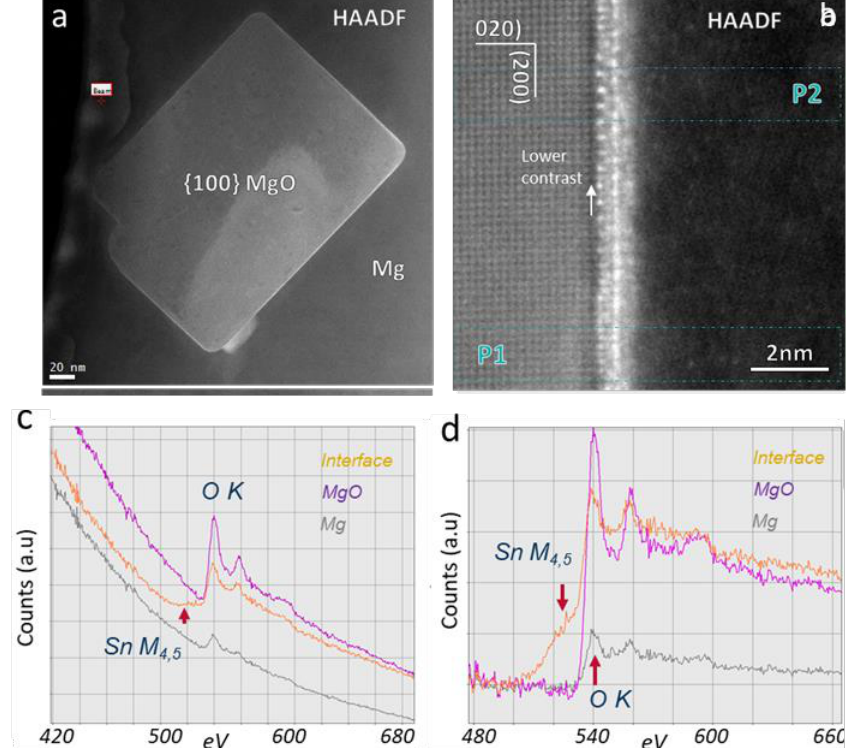
Figure 31. Sn segregation at Mg/(1 0 0)Mg interface [29]. ( a , b ) STEM HAADF images showing ( a ) general view of a {1 0 0} cubic MgO and ( b ) the Mg/MgO interface viewed in [0 0 1]MgO direction; and ( c , d ) the EELS spectra without and with background subtraction suggesting that Sn exists at the interface (indicated by the